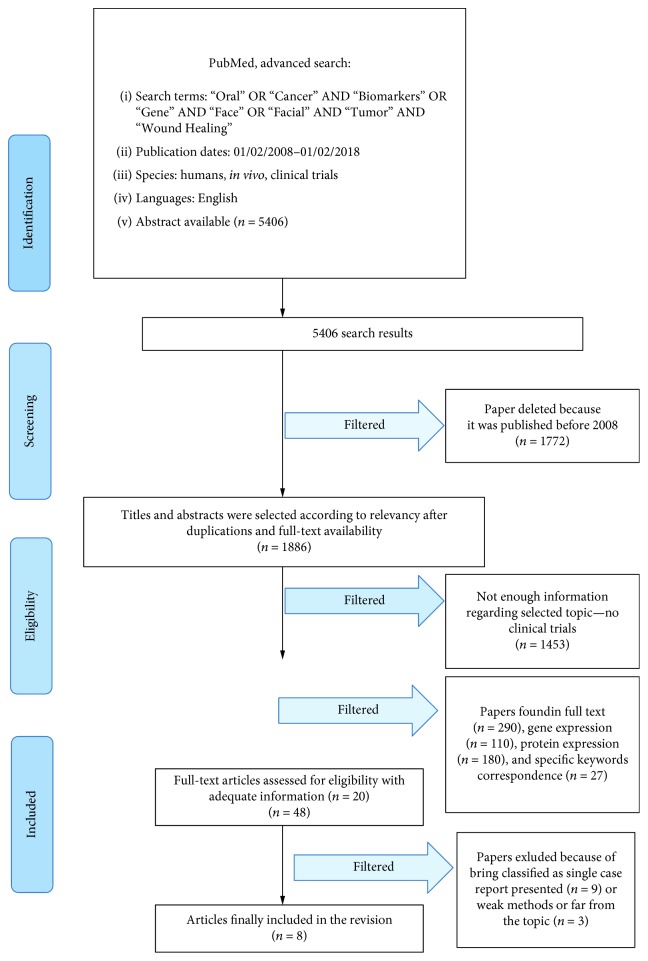
Prisma flow diagram.